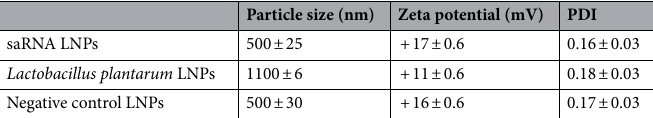
Table 1. The characterization of LNPs used in this study.